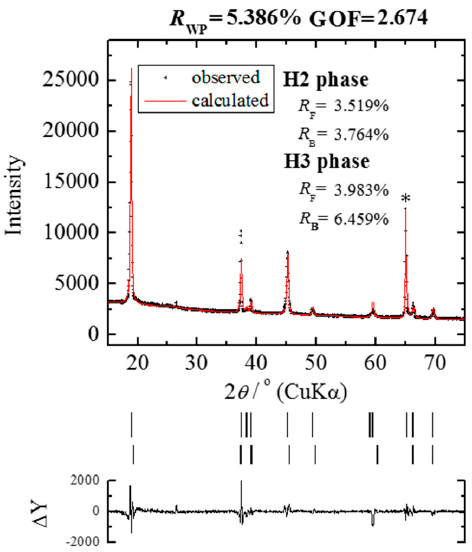
Figure 3. Observed and the Rietveld refined diffraction patterns of Li x Ni 0.874 Co 0.090 Al 0.036 O 2 (x = 0.09) after 30 h of relaxation from the termination of lithium extraction. The vertical lines in the middle section show the positions of peaks calculated for Bragg reflection. The trace ( ∆ Y ) in the bottom section represents the difference between observed and calculated patterns. The asterisk mark (*) indicates diffraction peaks of the aluminum foil collector.